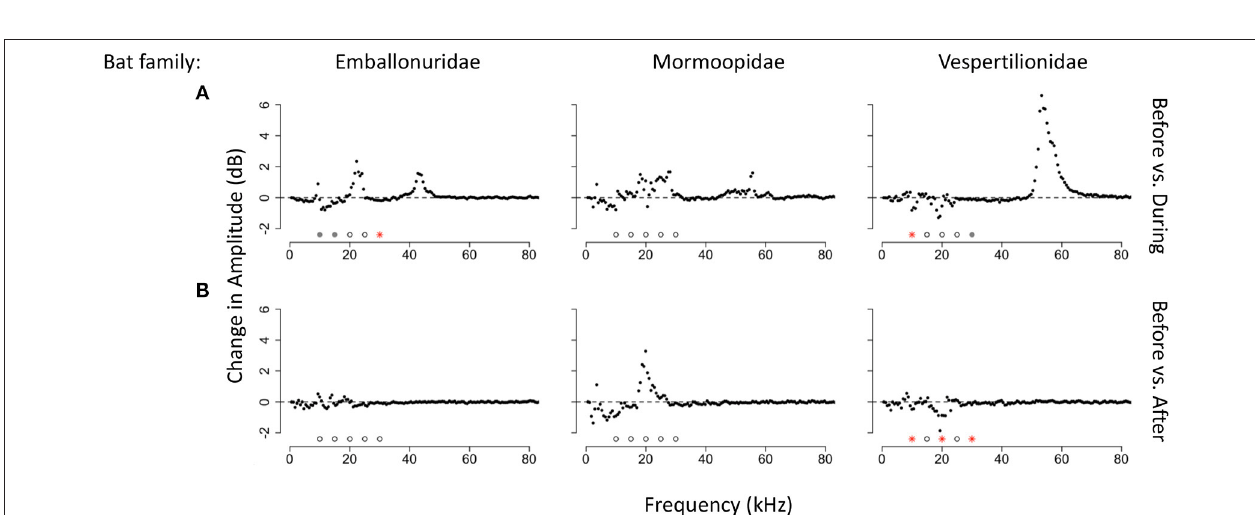
FIGURE 6 | Median changes in amplitude by frequency and bat family. (A) Median amplitude change comparing time bins before and during a bat echolocation sequence. (B) Median amplitude change comparing time bins before and after a bat echolocation sequence. Significance was tested at 5kHz intervals from 10 to 30kHz. Significant differences are shown with red asterisks (Wilcoxon paired ranks sums tests, p < 0.05), marginally significant differences are shown with gray circles (0.05 < p < 0.1), and tests that were not significant are shown with open circles.